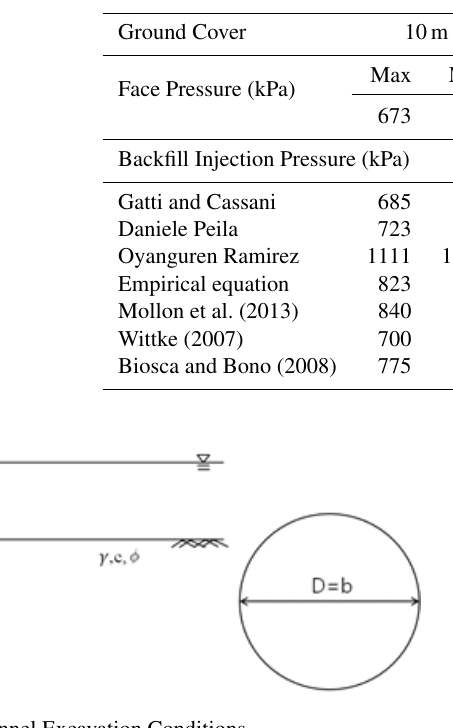
Table 2. Face and backfill pressure for numerical analysis (Case 5).